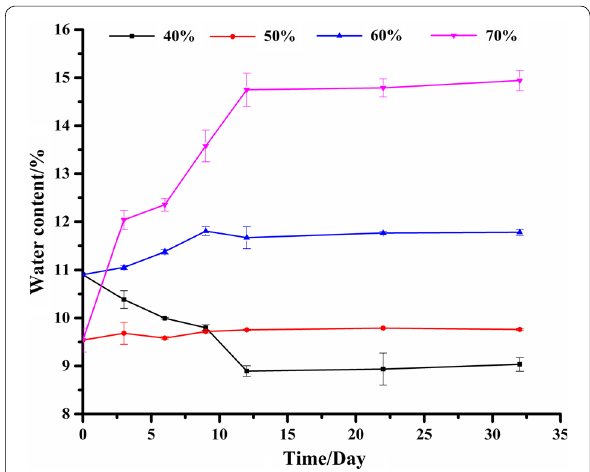
Fig. 2 Water content of lotus seeds stored at 25 °C and different relative humidity